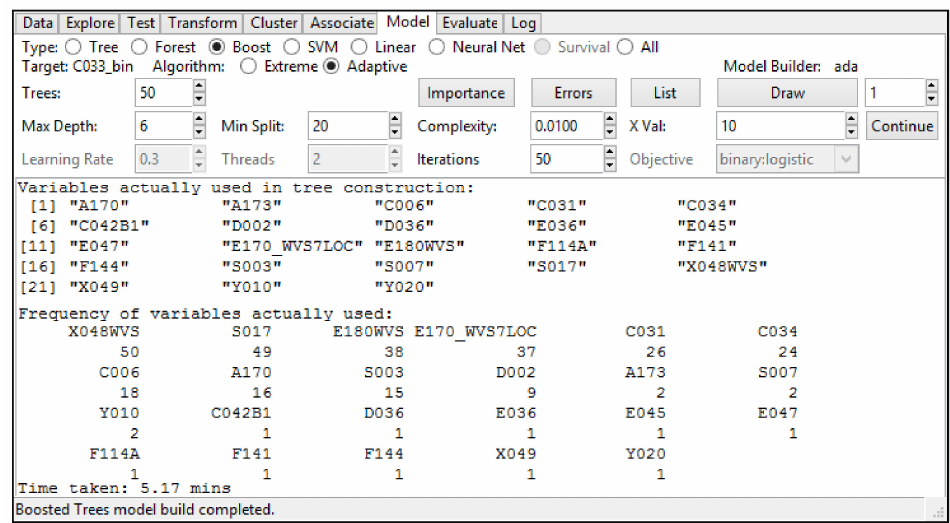
Figure 1. The results of the 1st round of data mining obtained using the Adaptive Boosting technique in